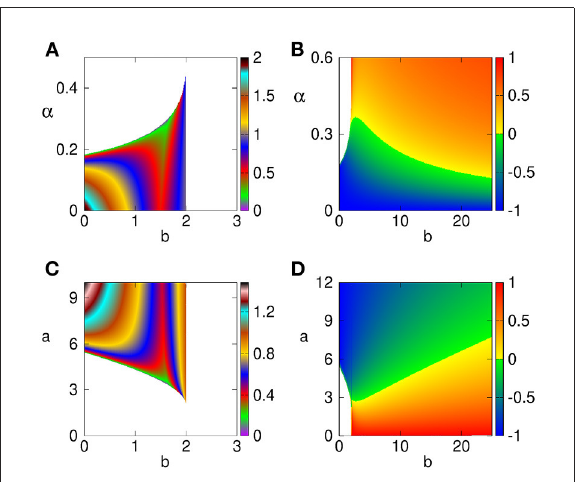
FIGURE2 Regions of feasibility and stability of steady states E 1 (A,C) and E 2 (B,D) . Steady states are feasible in a colored region, and biologically infeasible in the white region. Color code denotes the largest real part of characteristic eigenvalues. Parameter values are a = d = 1 (A,B) , α = d = 1 (C,D)